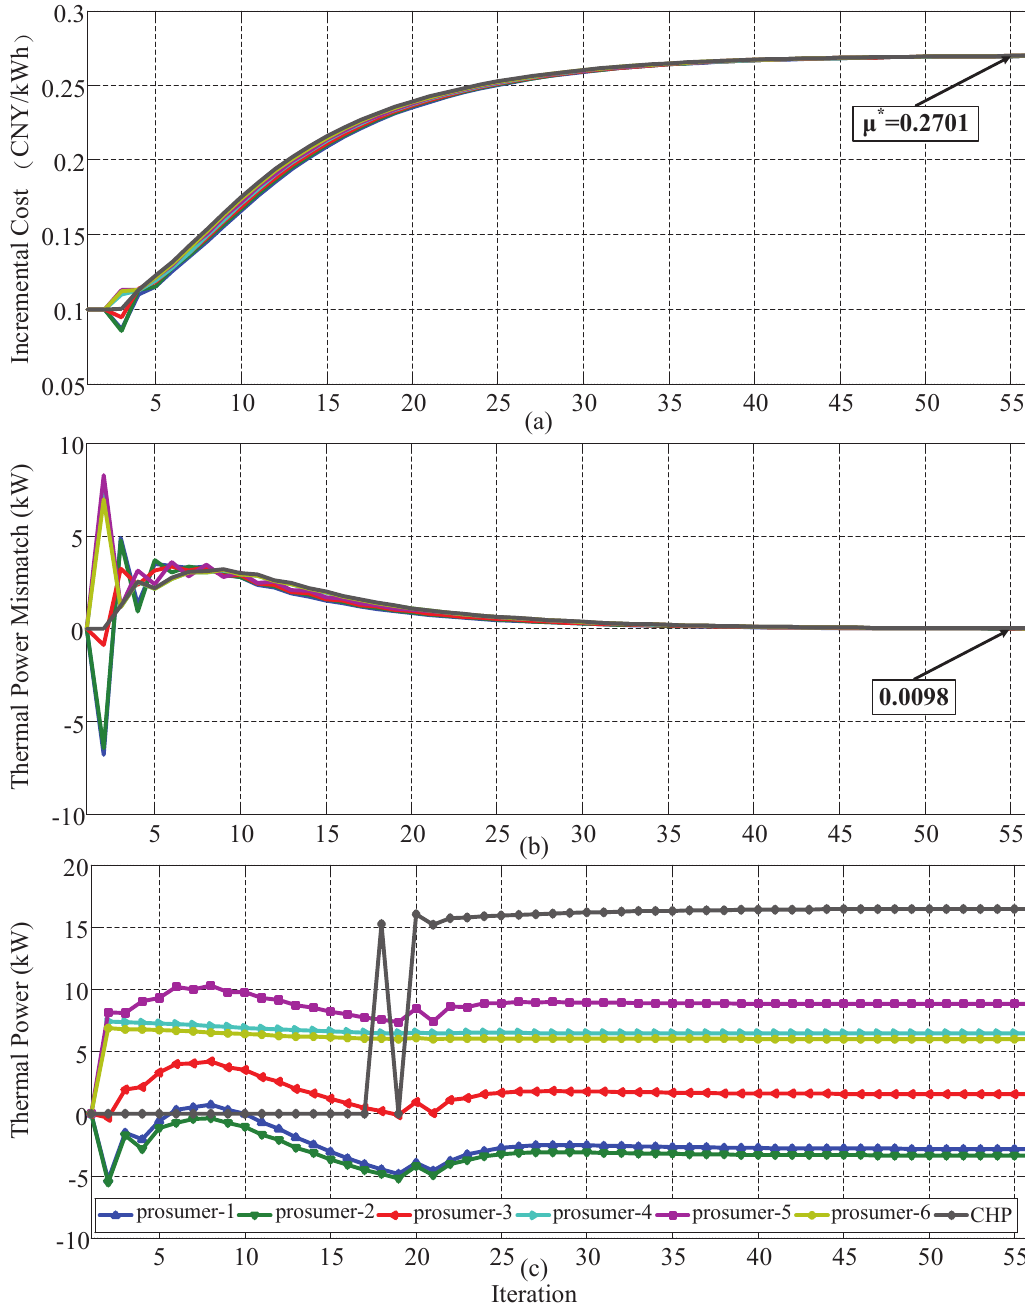
Figure 3. Convergence results of thermal network: ( a ) incremental cost (utility); ( b ) local thermal power mismatch; ( c ) local generated or consumed thermal